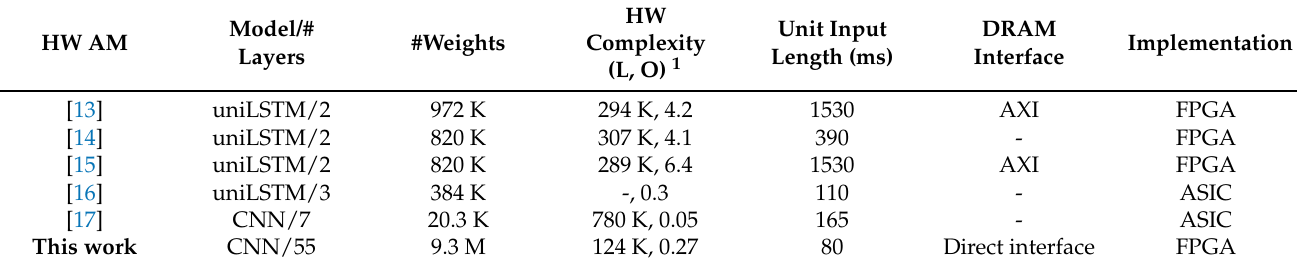
Table 1. Comparison of recently published hardware AM for